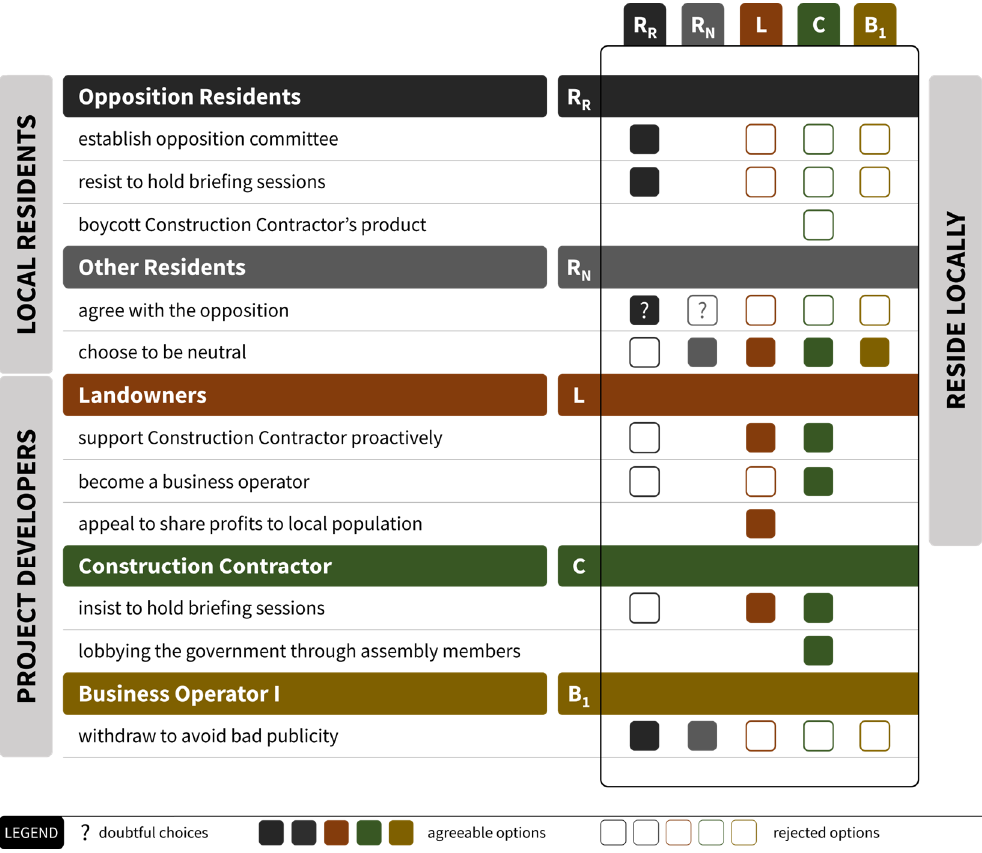
Figure 4. Actors, their options of actions, and their positioning over the options of other actors.